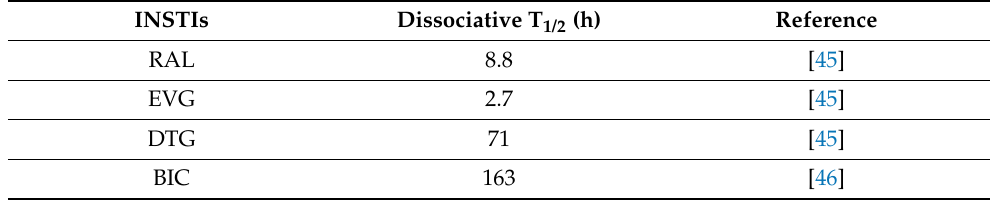
Figure 2. Chemical structures of the clinically relevant INSTIs. The chelating motifs which interact with Mg 2+ cofactors in the integrase active site are highlighted in the red square. The halobenzyl moieties, which are connected to the centralized pharmacophore by a linker group, are in the blue circle. These chemical structures have been drawn using ChemDraw software. Table 1. Dissociation half-life (T 1/2 ) of